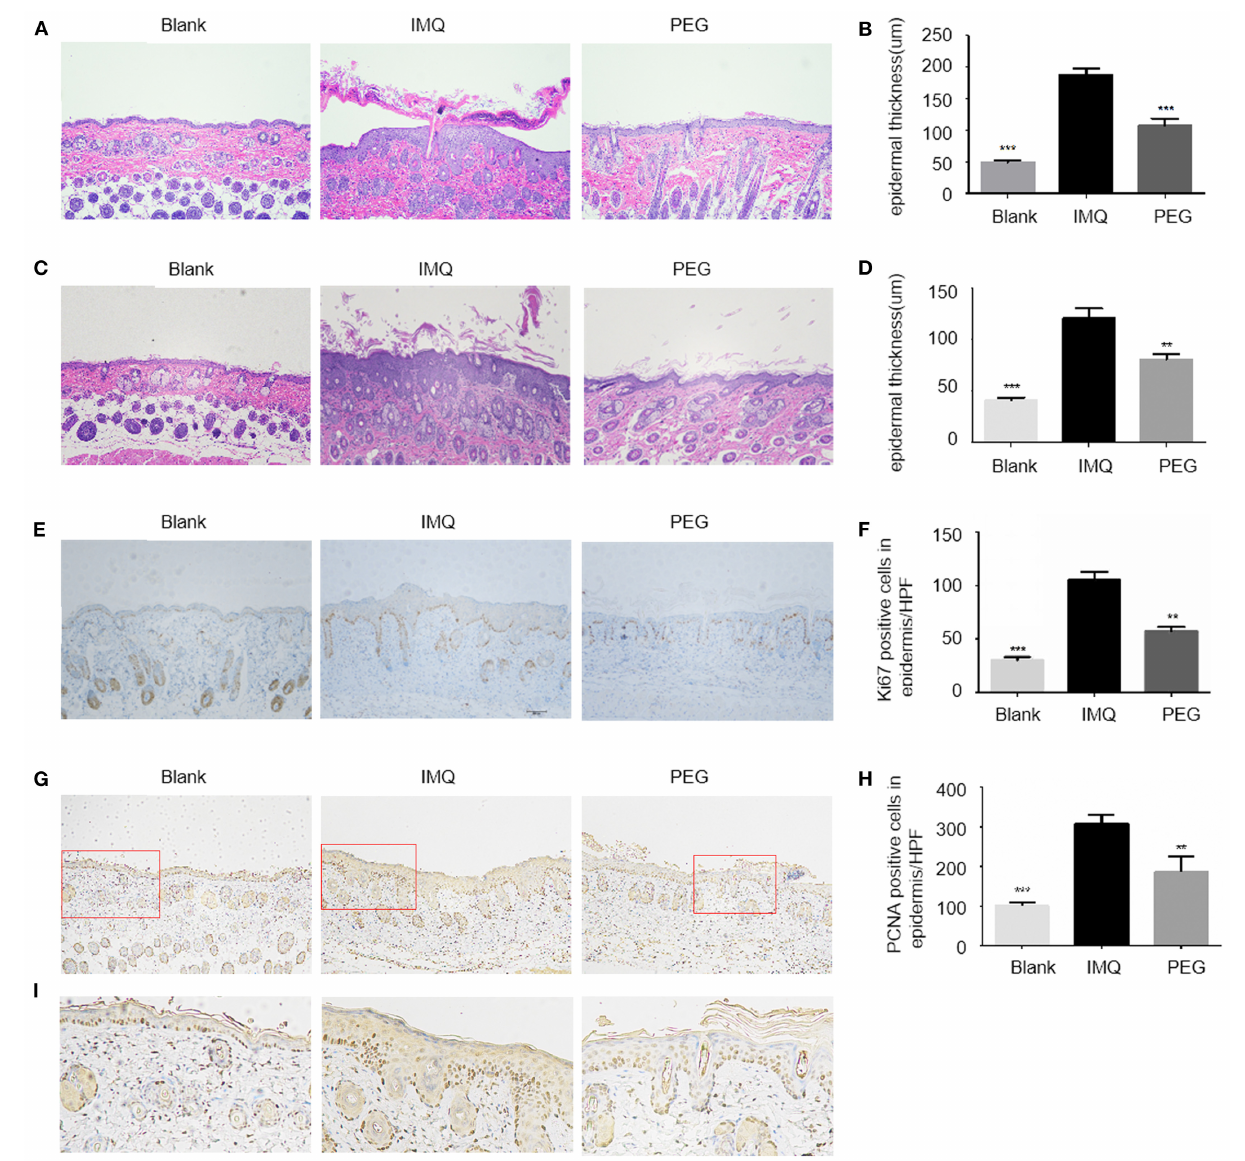
FIGURE 2 | (A,C) HE staining of lesion, with one representative for each group. (A) HE staining result of the 7-day model (100 × ). (B) The columnar statistical graph of the epidermal thickness of each group of the 7-day model (*compared with the IMQ group, *** P < 0.001). (C) HE staining result of the 21-day model (100 × ). (D) The columnar statistical graph of the epidermal thickness of each group of the 21-day model (*compared with the IMQ group, ** P < 0.01, *** P < 0.001). (E) The immunohistochemistry staining of Ki67. It can be seen that the brown particles in the basal part of the epidermis are Ki67-positive expression (100 × ). (F) A bar graph of the number of Ki67-positive expressions/HPF in the basal part of the epidermis (*compared to the IMQ group, ** P < 0.05, *** P < 0.001). (G) The immunohistochemistry staining of PCNA. It can be seen that the brown particles in epidermis are PCNA-positive expression (100 × ). (H) A bar graph of the number of PCNA-positive expressions/HPF in epidermis (*compared to the IMQ group, ** P < 0.05, *** P < 0.001). (I) A partial enlarged view of PCNA staining from the red box in (G) . All statistical graph and data analysis were finished by GraphPad Prism 5 software. We have repeated the experiment more than three times.